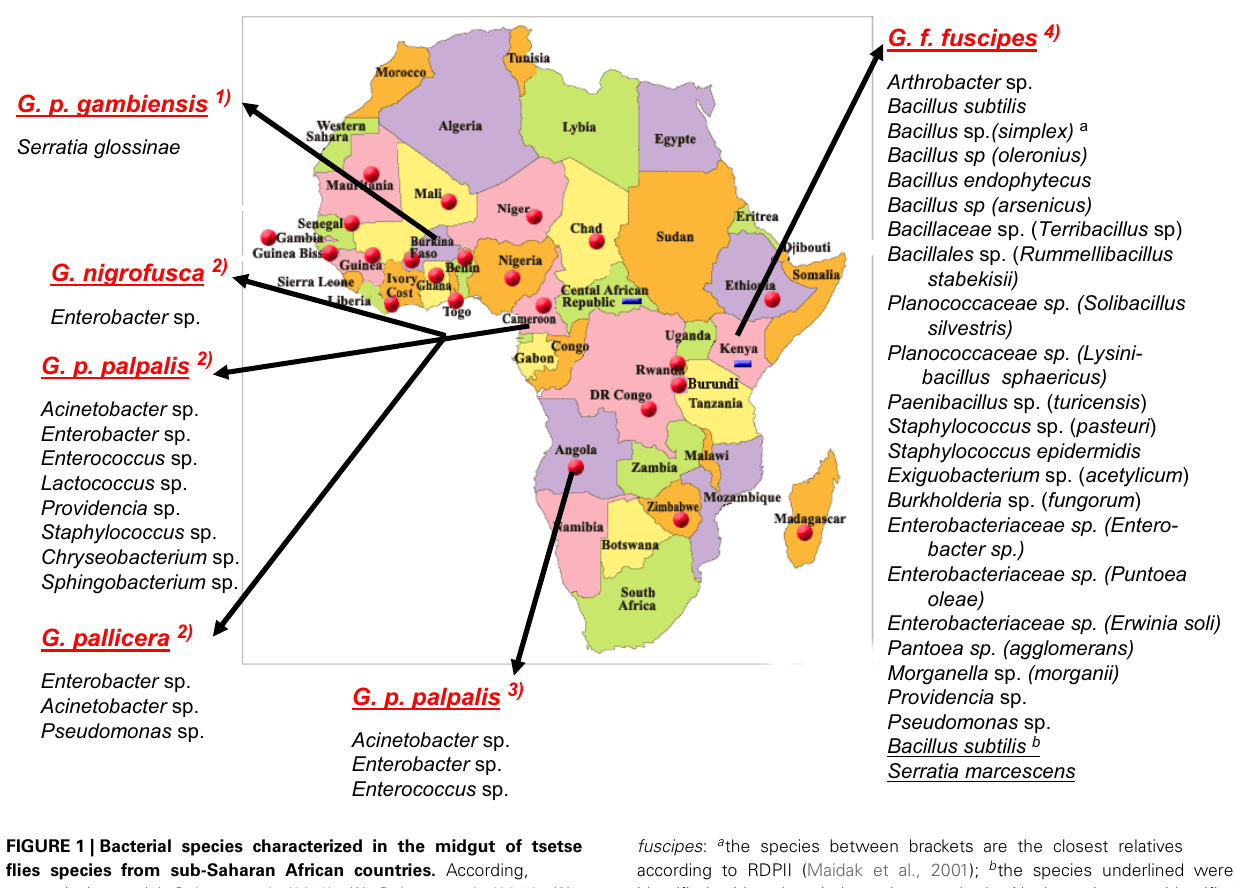
FIGURE 1 | Bacterial species characterized in the midgut of tsetse flies species from sub-Saharan African countries. According, respectively, to: (1) Geiger et al. (2010); (2) Geiger et al. (2011); (3) Geiger et al. (2009); (4) Lindh and Lehane (2011). Bacteria from G. f.